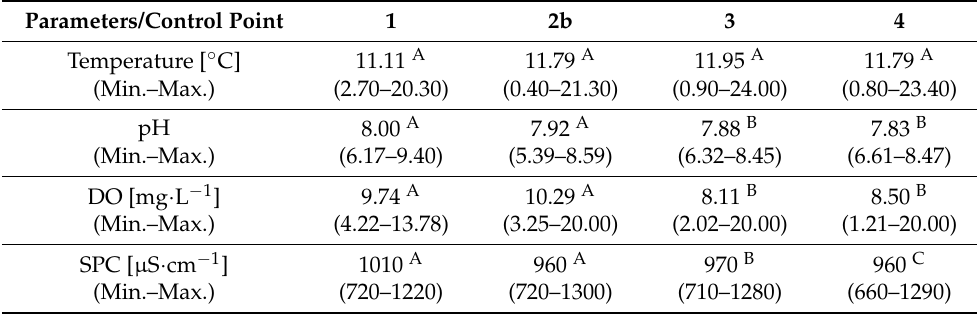
Table 1. Characteristics of the physical parameters of water flowing through the SED-BIO system. Different letters mean a significant difference between control sites for each parameter in the Wilcoxon signed-rank test with p < 0.05, n = 36.